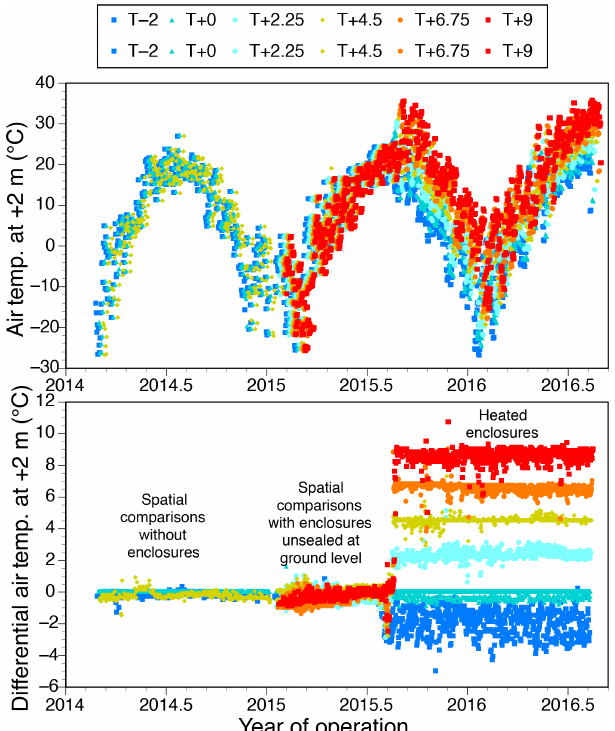
Figure 4. Daily mean air temperatures (upper graph) and the asso- ciated air temperature differentials at + 2m above the bog surface (lower graph) by treatment plots since 2014, including periods prior to enclosure construction (through January 2015), a period when upper enclosures were in place (January to July 2015), and observa- tions since full enclosure of each plot was achieved (27 July through 5 August 2015). Interior blower function was initiated at the time of full plot enclosure. The sustained period of warming began at 14:00 on 12 August 2015. Differential temperatures are referenced to sen- sors within the fully constructed but no-energy-added control plot 6. Unchambered ambient plot data are also shown as T − 2